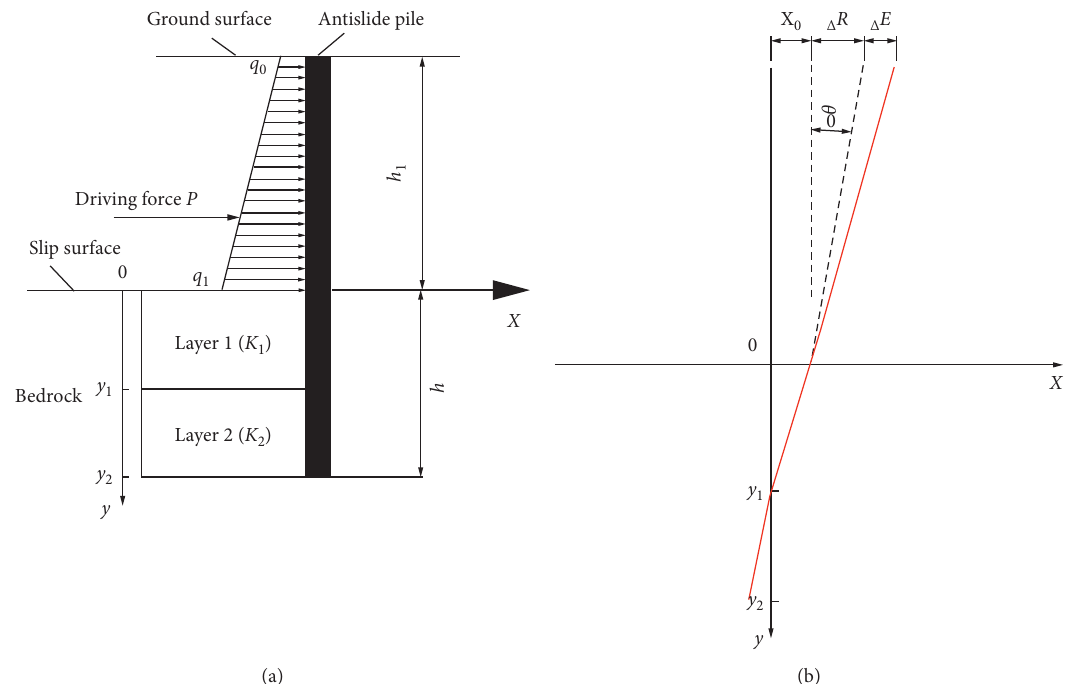
Figure 1: Stress and deformation model of an antislide pile under a trapezoidal load in two different strength strata. (a) Sketch of the lateral trapezium load acting on a pile. (b) Composition of antislide pile